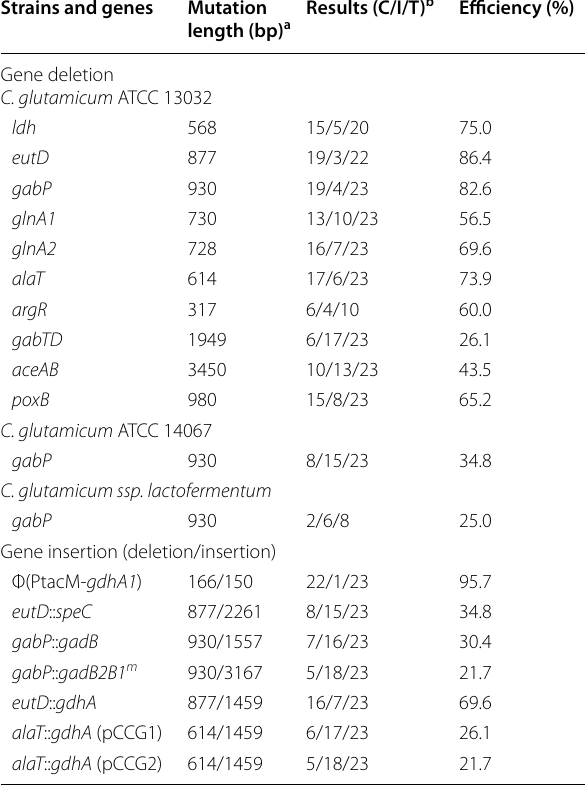
Fig. 3. The concentration of the l-Glutamic acid reached